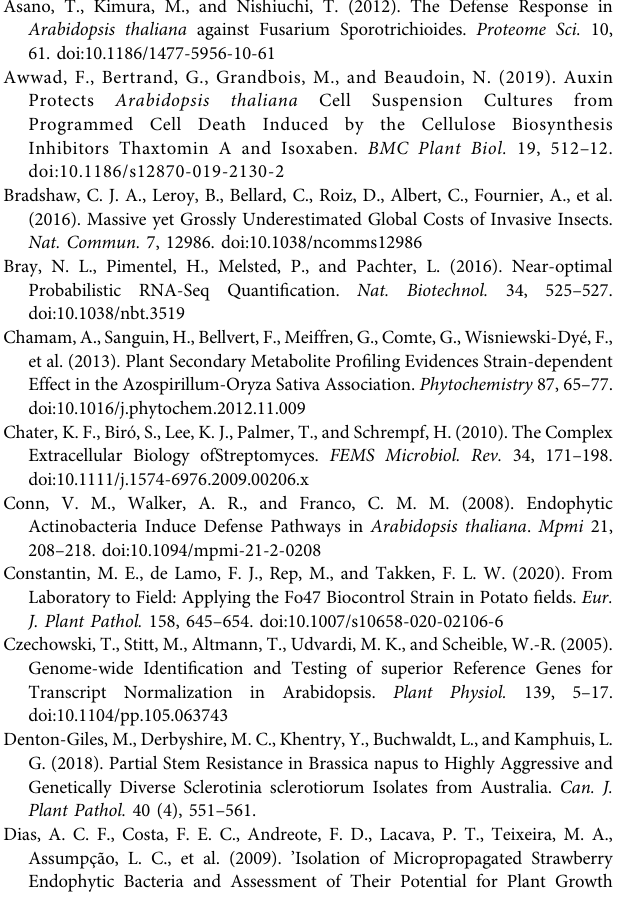
Supplementary Table S6 | Comparison of RNAseq results with Vergnes et al. ’ s fi ndings.ListedaregenesfoundinbothRNAseqstudies.Log2foldchangefromthis study and upregulation and downregulation of genes from the Verges publication are